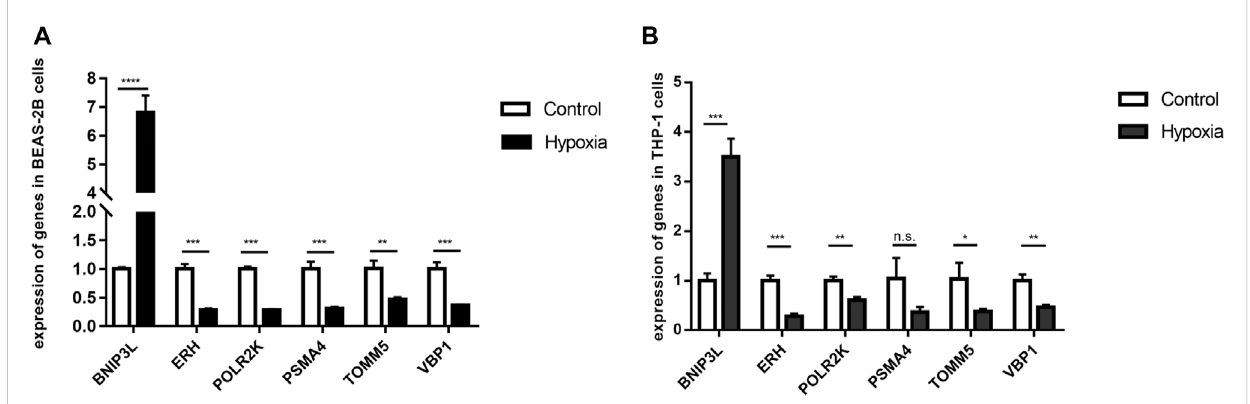
FIGURE 9 mRNA levels of six hub genes were different in control and hypoxia groups by veri fi ed by qRT-PCR results. p < 0.05 (*), p < 0.01 (**), p < 0.001 (***) and p < 0.0001 (****) were considered signi fi cant. (A) BEAS-2B cells. (B) THP 1